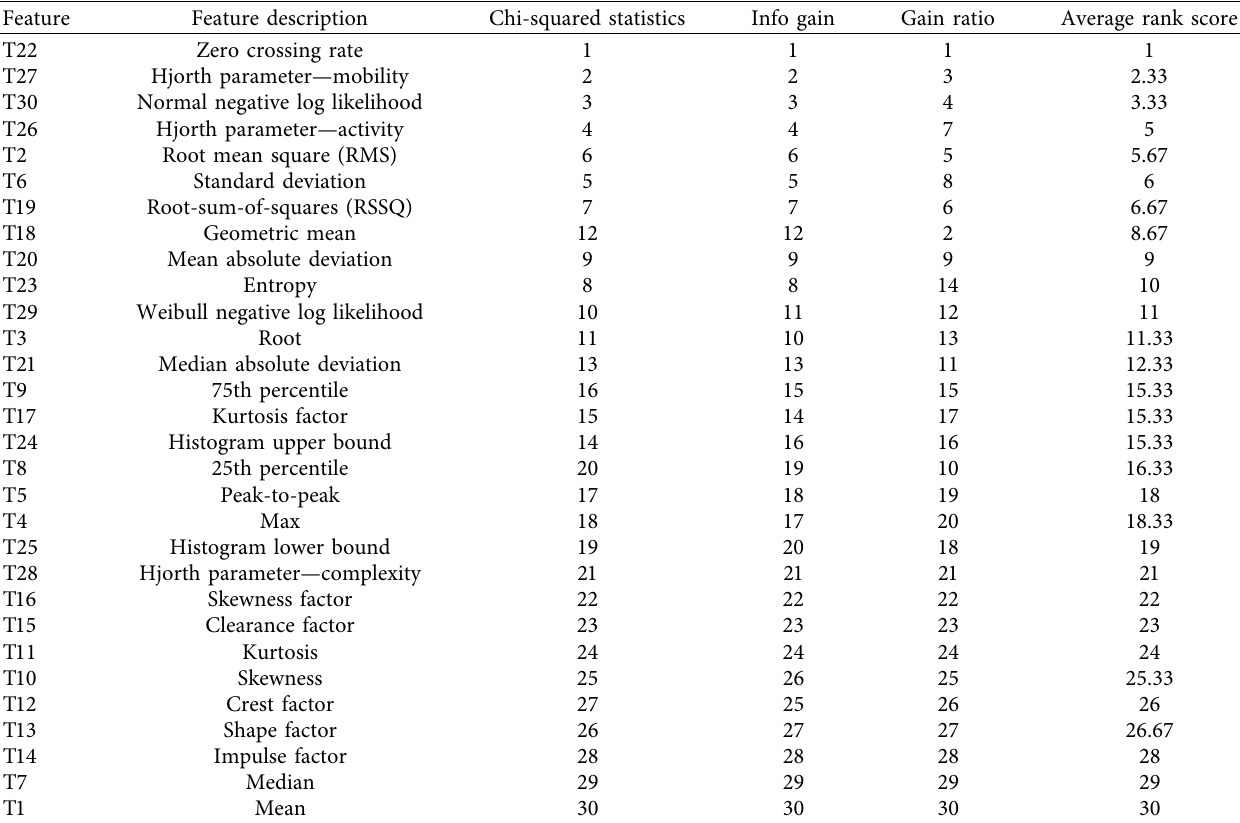
Table 5: Feature ranking of statistical features for dataset A.